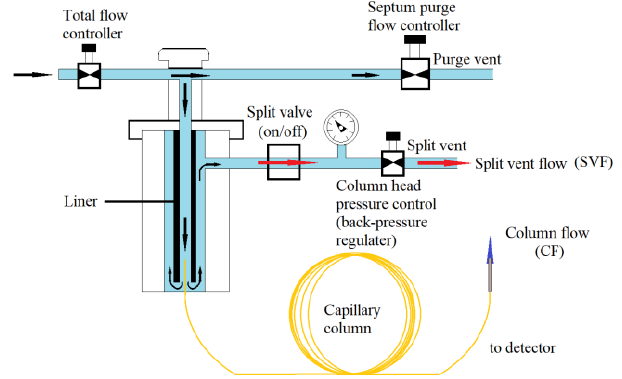
Figure 4. Schematic diagram of split/splitless injection of a GC inlet.